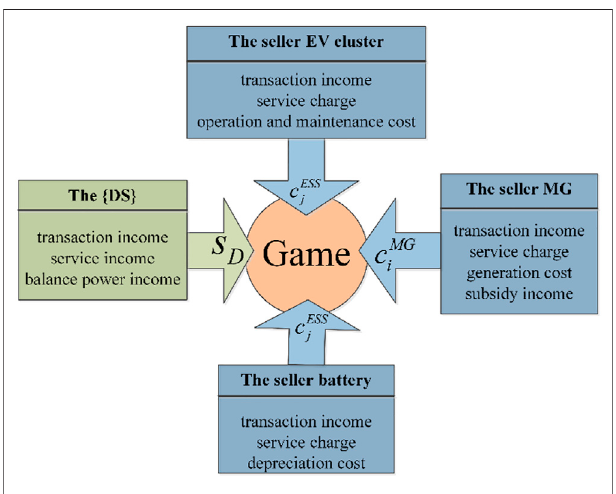
FIGURE 1 | Game structure of multi-stakeholder and the {DS} transaction